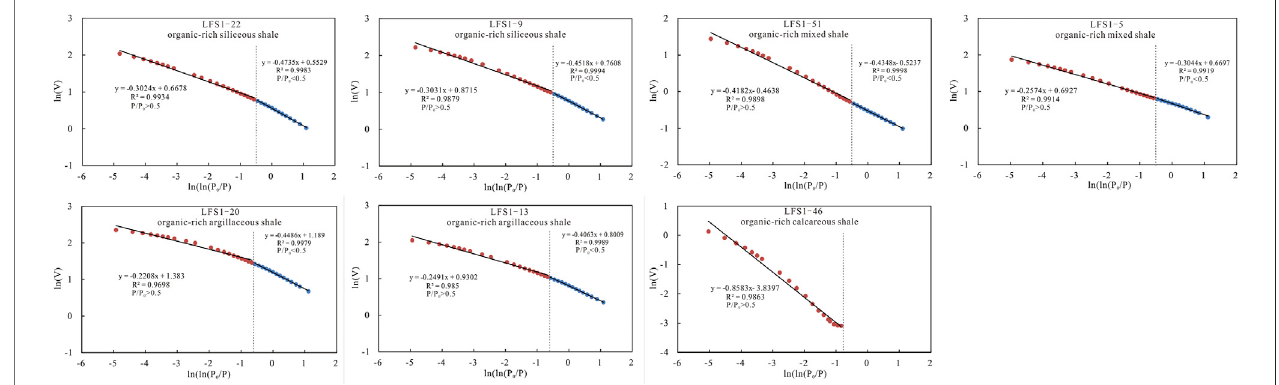
FIGURE 11 | Scatter diagram of ln (V) vs. ln (ln (P 0 /P)) from N 2 adsorption data for shale samples from the Shahezi Formation.